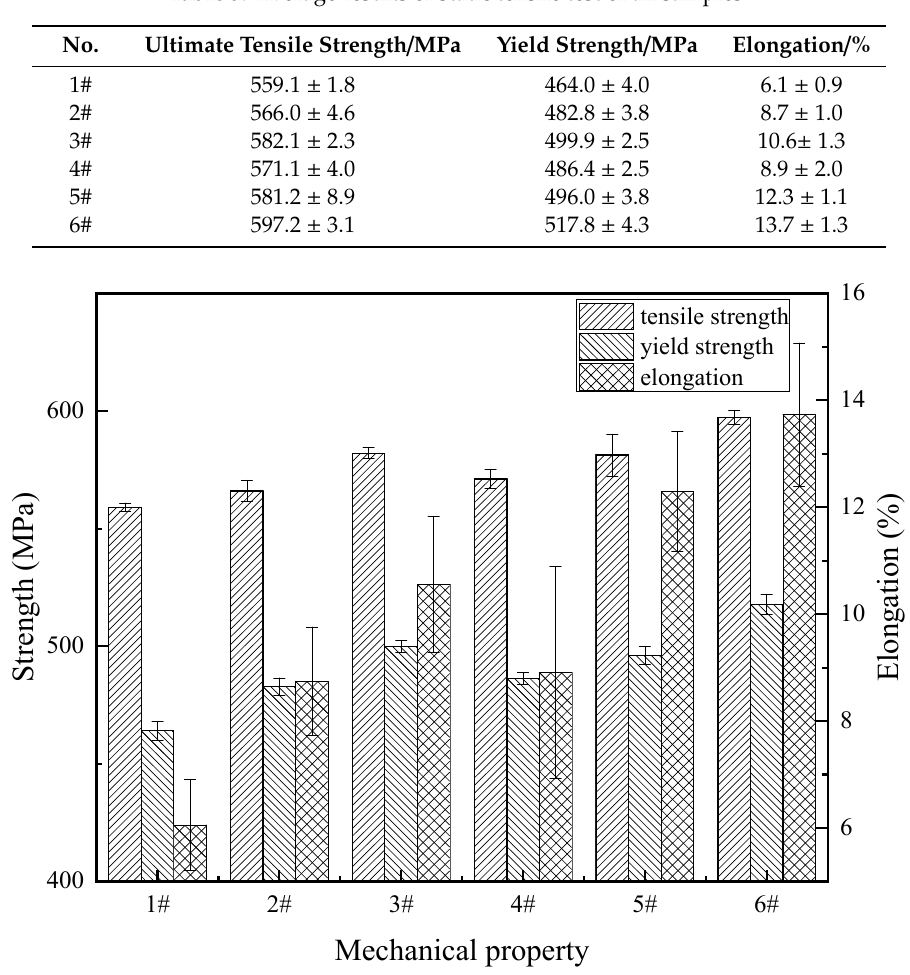
Figure 10. Static tensile mechanical properties of all samples.